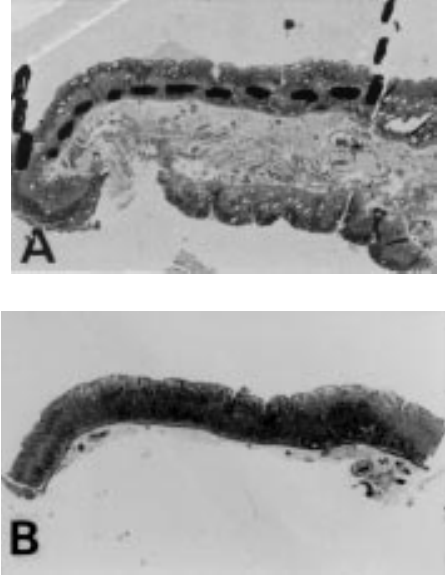
Fig. 1. (A) Shows a section from an EGC before microdissec- tion. Note doted line limiting the area to be dissected (HE, (cid:2) 2.4). (B) Illustrates the dissected sample used for ploidy assessment (HE, (cid:2)